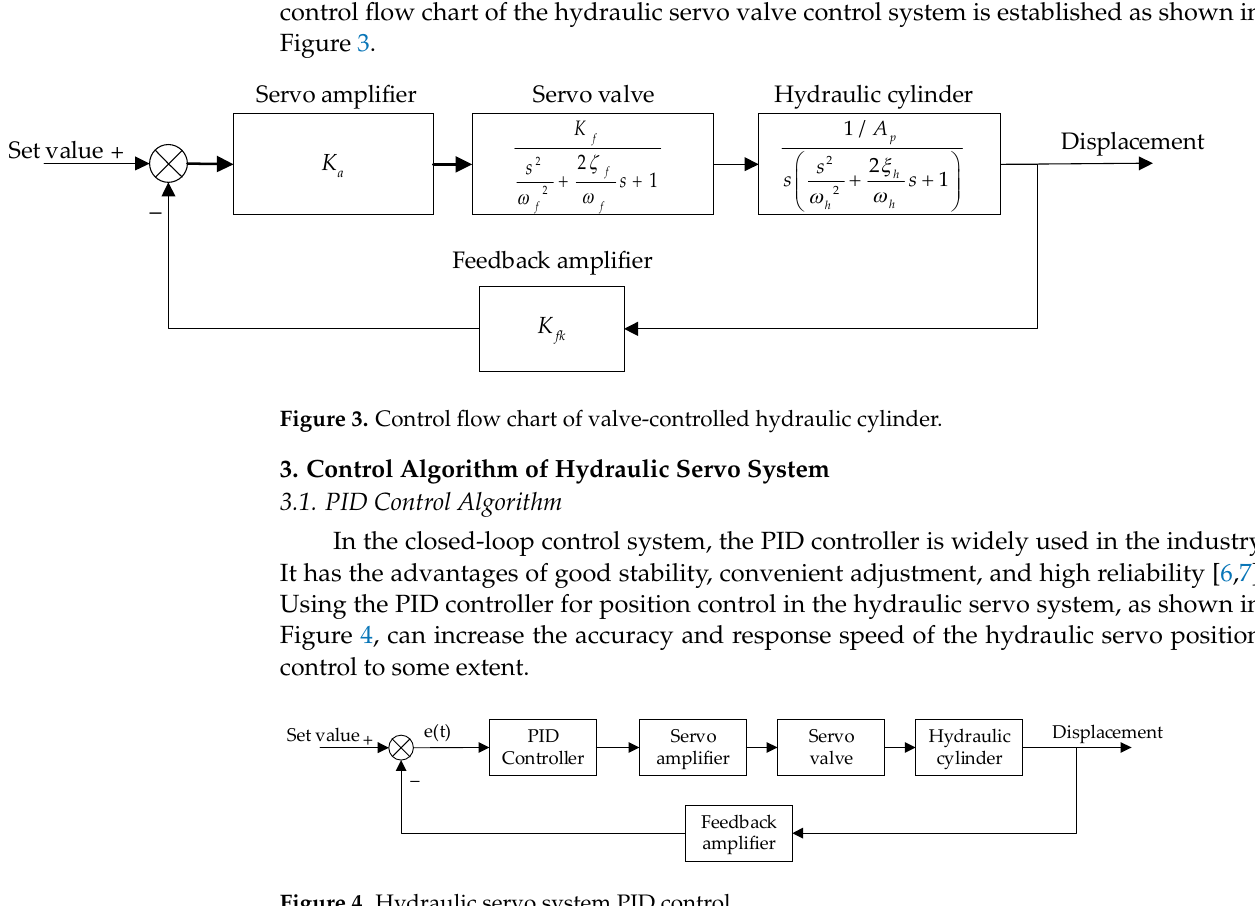
Figure 4. Hydraulic servo system PID control.